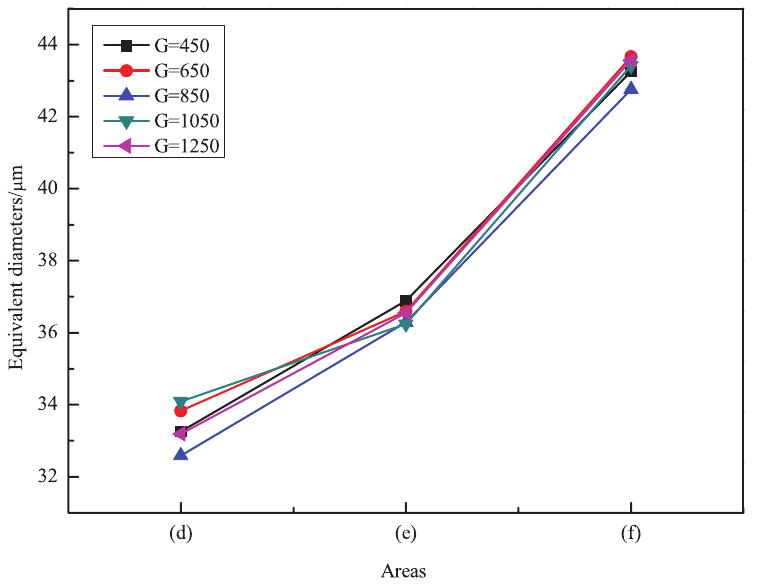
Fig. 6: Variations of equivalent diameters of V-containing spinel phase in different areas of the samples with different gravity coefficient at t = 30 min, T = 1523